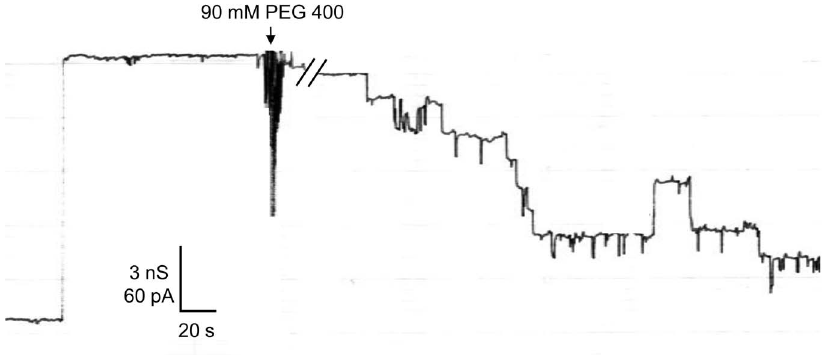
Figure 5. PEG 400-induced blockage of P66 on the single-channel level. Small amounts of highly diluted P66 (1:1,000 in 1% Genapol) was added to both sides of a diphytanoyl PC membrane. After reconstitution of one single 11 nS P66 unit, 90 mM PEG 400 was added to both sides of the membrane. The P66 conductance was blocked stepwise exhibiting subconductance steps of approximately 1.5 nS; temperature=20 u C; applied voltage=20 mV.